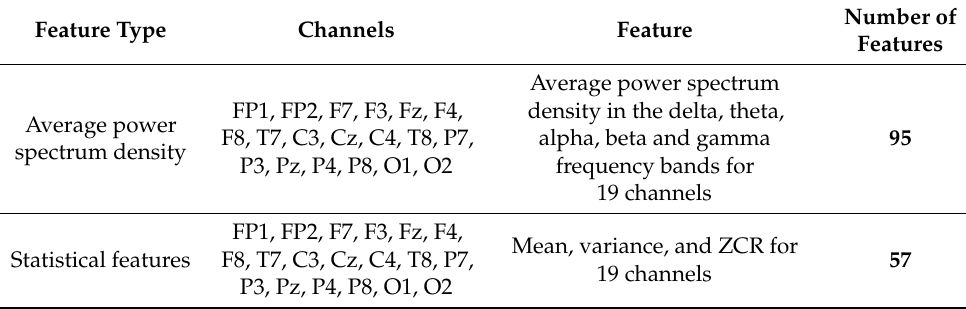
Table 1. Features extracted from electroencephalographic signals.